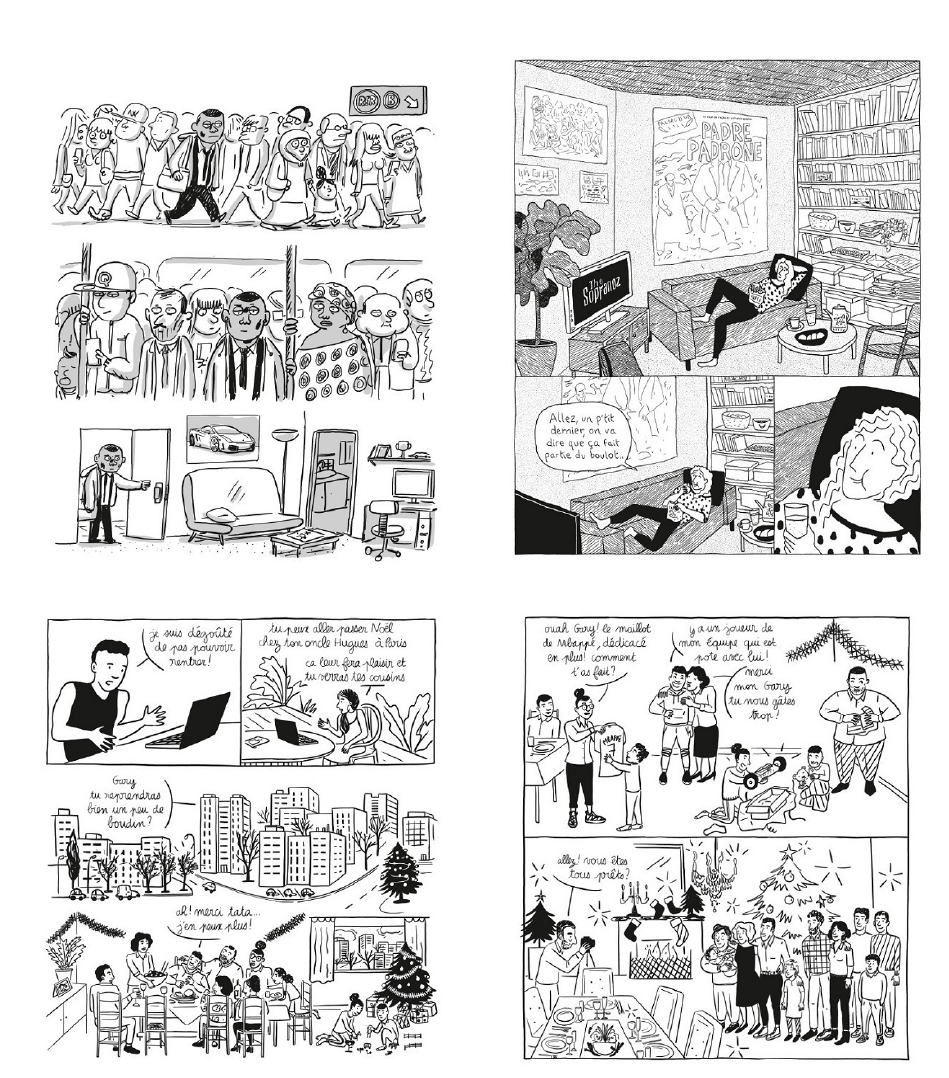
Figure 2: La fabrique pornographique, Trachman/Mandel ©CASTERMAN (above left); Plus belle la série, Mille/Landes/Harel ©CASTERMAN (above right); L’amour du Maillot, Rasera/Georges ©CASTERMAN